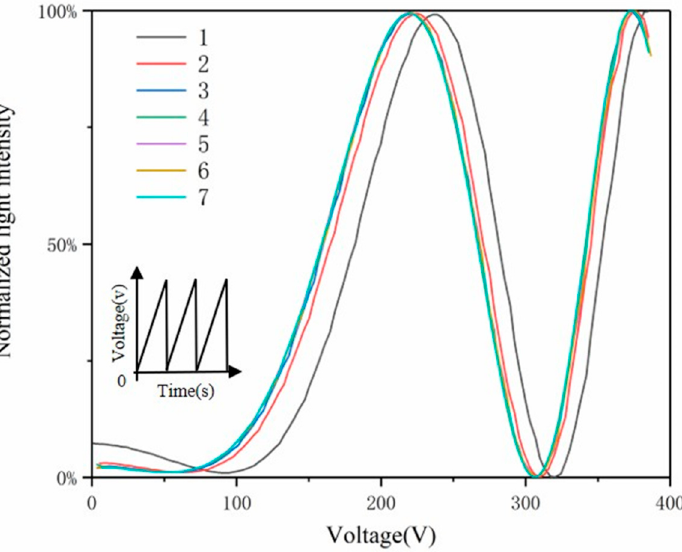
Figure 9. Modulated transmittance curves with a sawtooth wave voltage. (The inset of the lower left corner of the figure is the applied sawtooth wave voltage, and the numbers represent each cycle of the applied voltage.).